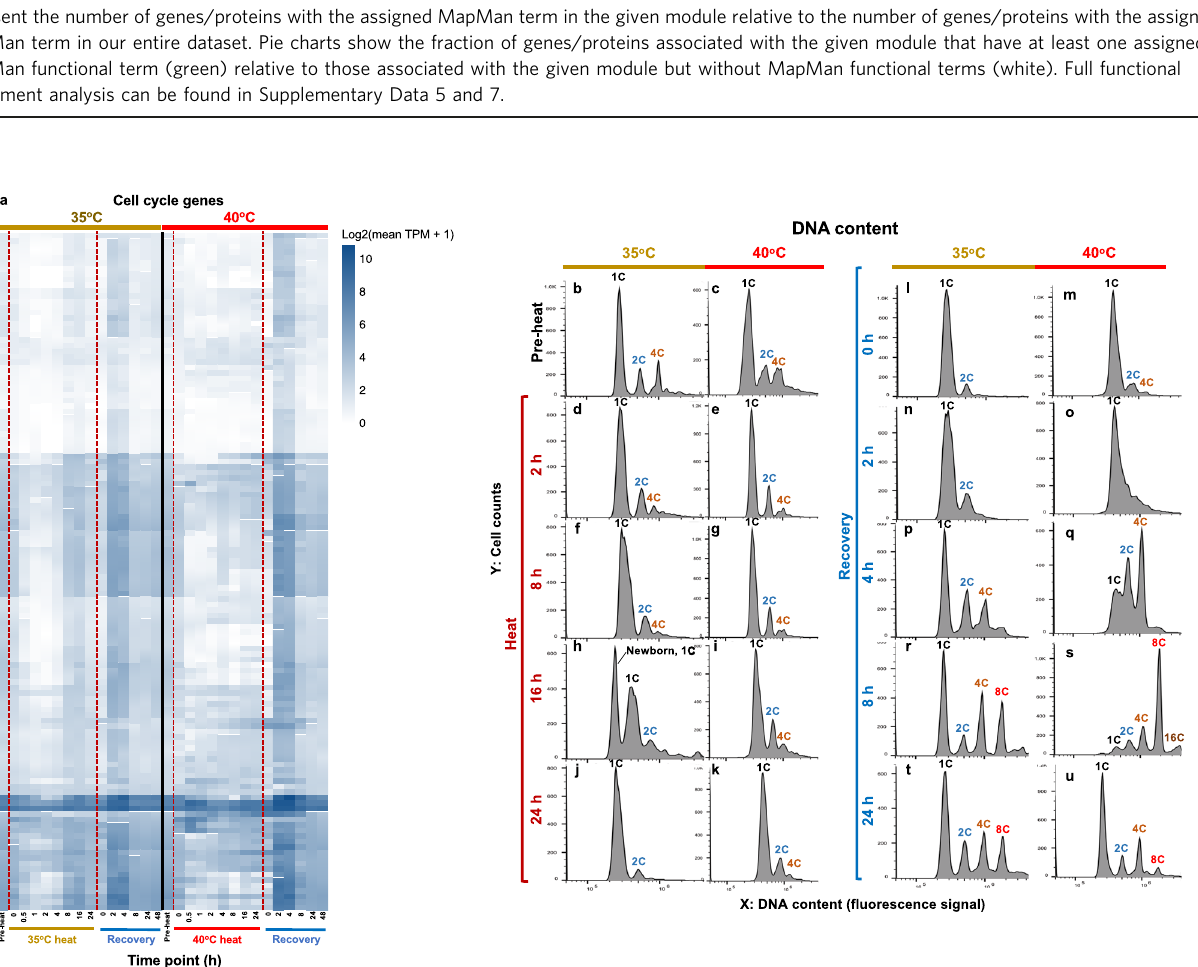
Fig. 4 Heat at 35°C synchronized the cell cycle while heat at 40°C arrested it. a Expression of cell cycle genes during and after heat treatment of 35°C or 40°C. Genes used for the expression pattern analysis are listed in Supplementary Data 6. Gene expression patterns for treatments of 35°C (left) and 40°C (right) are displayed as log 2 (mean TPM value + 1). TPM, transcripts per million. Darker blue colors indicate higher expression. Red dashed lines indicate the start and end of the heat treatments. Pre-heat, before heat treatment. Time points during heat: 0 h, reach high temperature of 35°C or 40°C; 2 h, heat at 35°C or 40°C for 2 h, similar names for other time points during heat. Time points during recovery: 0 h, reach control temperature of 25°C for recovery after heat; 2 h, recovery at 25°C for 2 h, similar names for other time points during recovery. b – u FACS ( fl uorescence-activated cell sorting) analysis of the DNA content in algal samples harvested at different time points before, during, and after heat treatment at 35°C or 40°C. For each fi gure panel, X axis is DNA content determined by plotting a histogram of fl uorescence level (area of the fl uorescence channel signal) in log-scale; Y axis is the cell counts in linear scale. DNA copy No. are labeled on top of each corresponding DNA content peak, 1 C (single DNA copy number), 2 C, 4 C, 8 C, 16